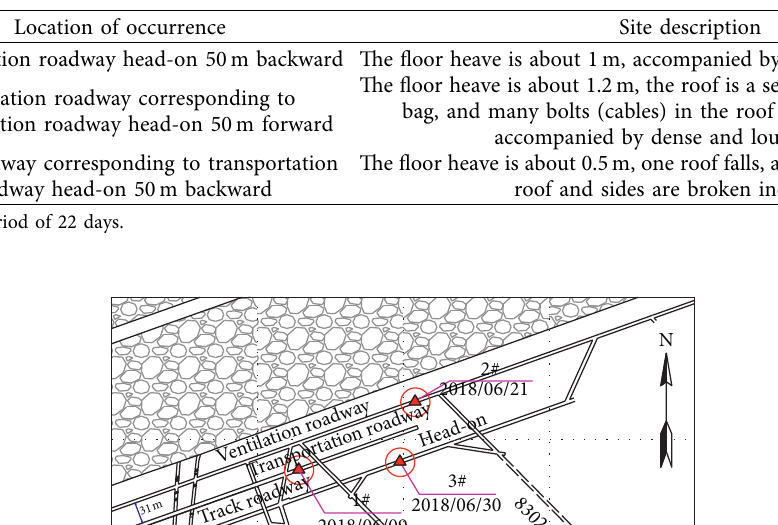
Table 2: Statistics of roadway rockburst in the third mining area.